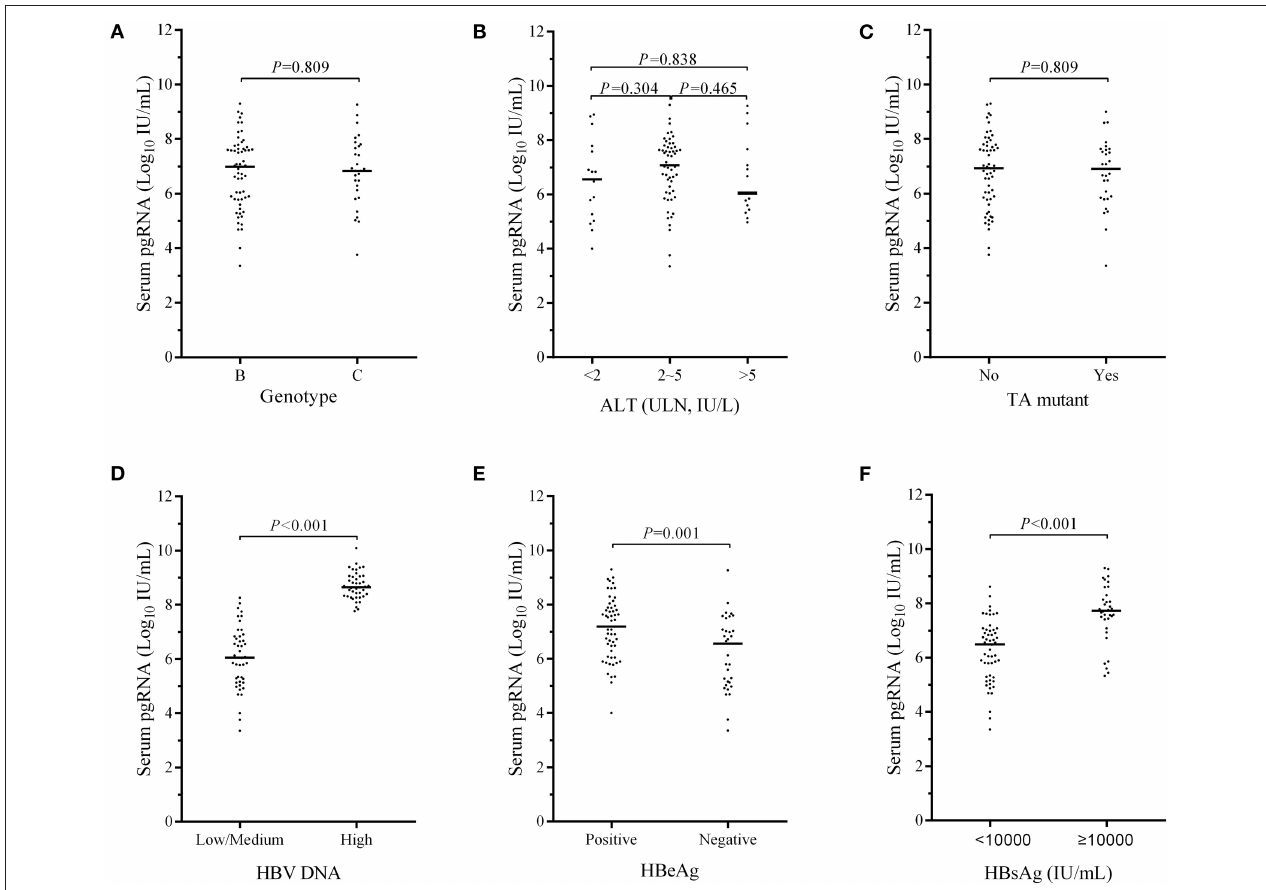
FIGURE 2 | Comparison of the baseline serum pgRNA levels in CHB patients of different subgroups, that is, in patients of different genotypes (A) , different ALT levels (B) , with or without TA mutant (C) , low/medium and high HBV DNA levels (D) , positive- and negative- HBeAg (E) , and different HBsAg levels (F) . P -values between the groups were calculated using chi-squared